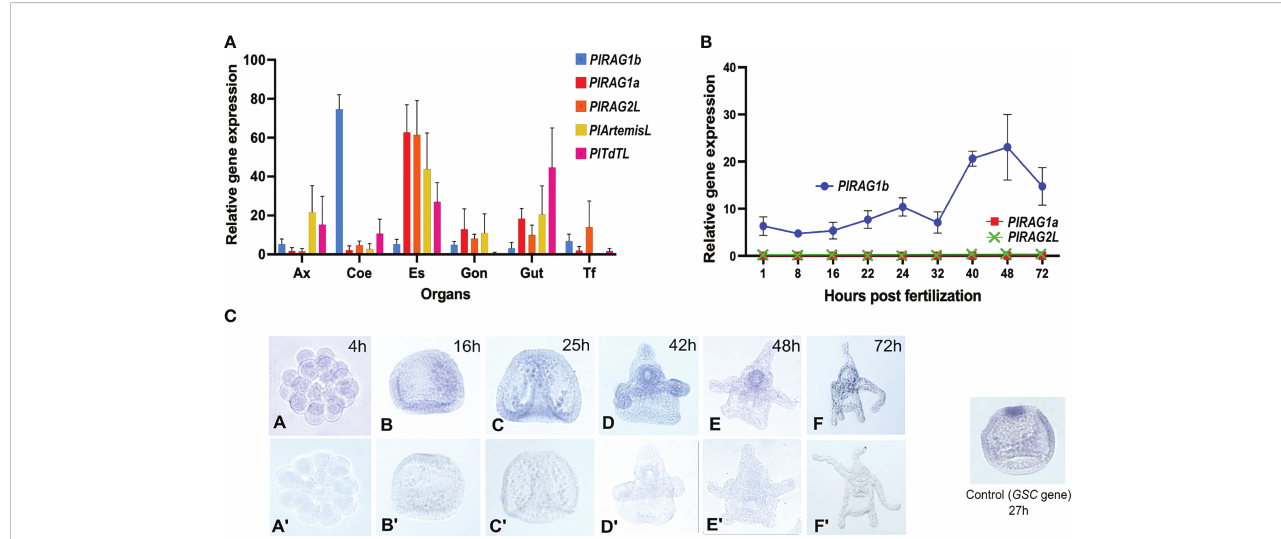
FIGURE 4 Expression patterns of PlRAGL1a, PlRAGL2, PlRAGL1b , PlArtemisL and PlTdTL genes in adult tissues and early developmental stages of P. lividus (A) . Relative gene expression in of the tested genes in adult sea urchin tissues and organs by qPCR. Ax - axial organ, Coe - coelomocytes, Es - esophagus, Gon - gonads, Gut, Tf - tubefeet. (B) . Relative gene expression of PlRAG1a and PlRAG1b in the early developmental stages by qPCR. The PlRAG2L expression is showed according to the PRJNA264358, PRJNA376650 and PRJEB10269 RNA-seq databases. (C) . PlRAG1b expression in the